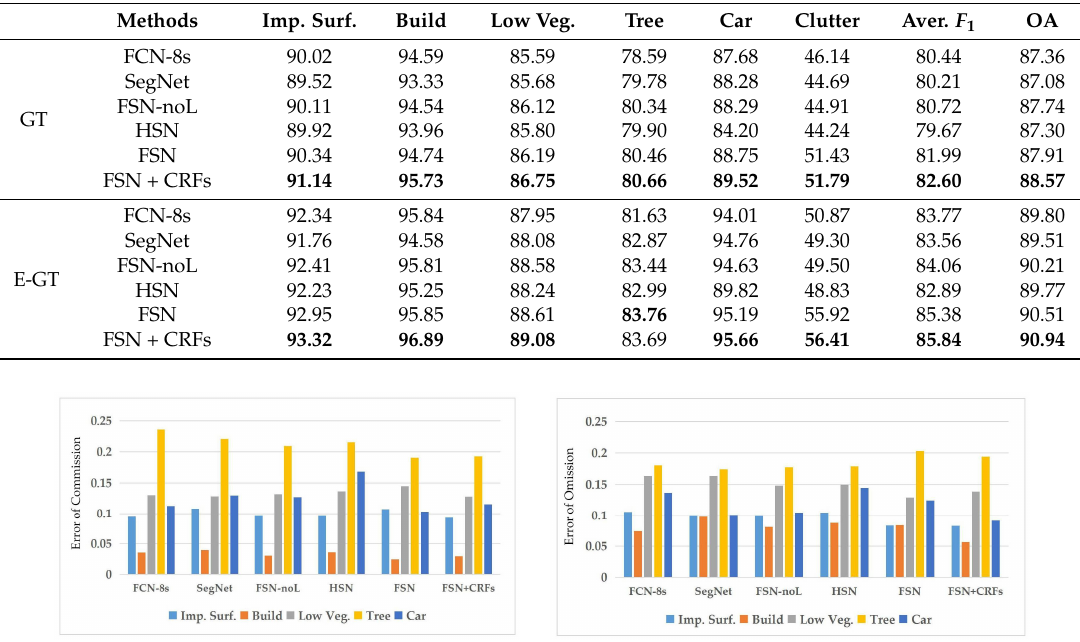
Table 6. Experimental results on Potsdam test set.